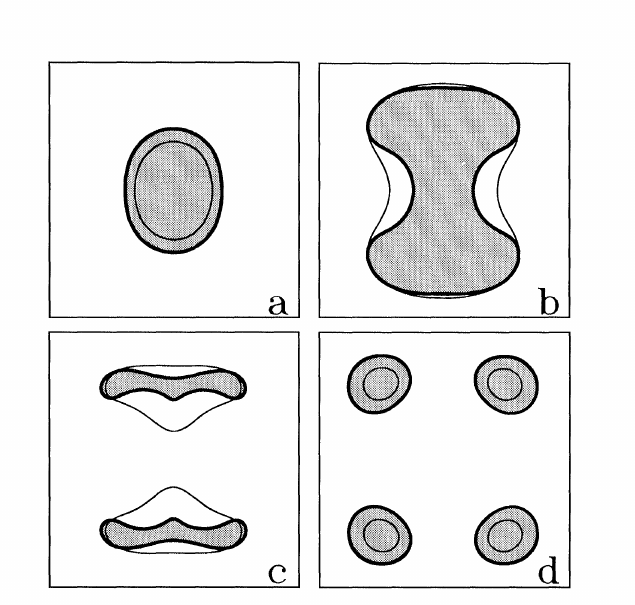
FIGURE 8 Domain splitting induced by curvature varia- tions in time. Local front transitions occur at the flatter portions of the expanding front. They are accompanied by the nucleation of pairs of spiral waves (the crossing points of the thick and thin lines), and followed by domain split- ting. The pictures were obtained by numerical integration of Eq. (5)close to the front bifurcation. Parameters: a0=